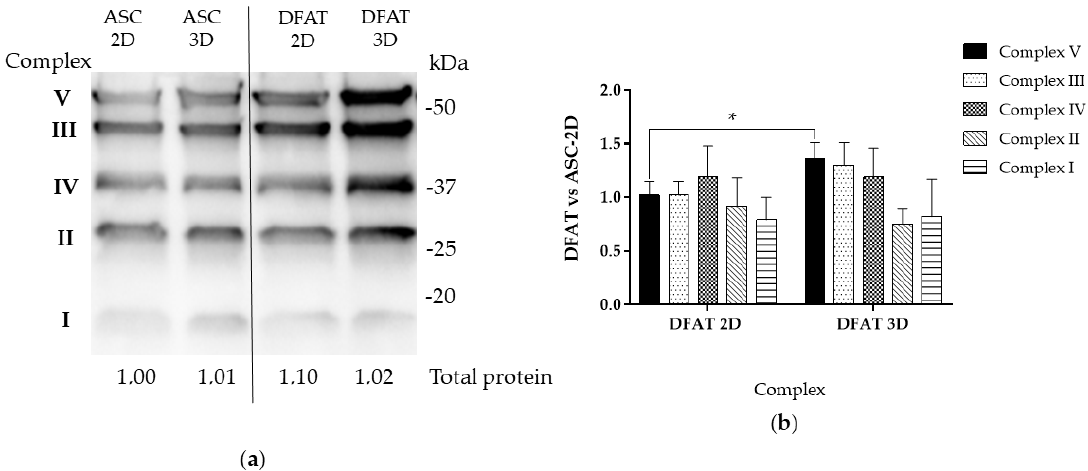
Figure 10. Assessment of protein levels of selected subunits of OXPHOS complexes. ( a ) Representa- tive blot ( b ) Relative amounts of proteins counted in relation to ASC-2D. The results are presented as mean values of 3 – 5 biological replications and are normalized per µg of protein ± SD, for * p < 0.05.